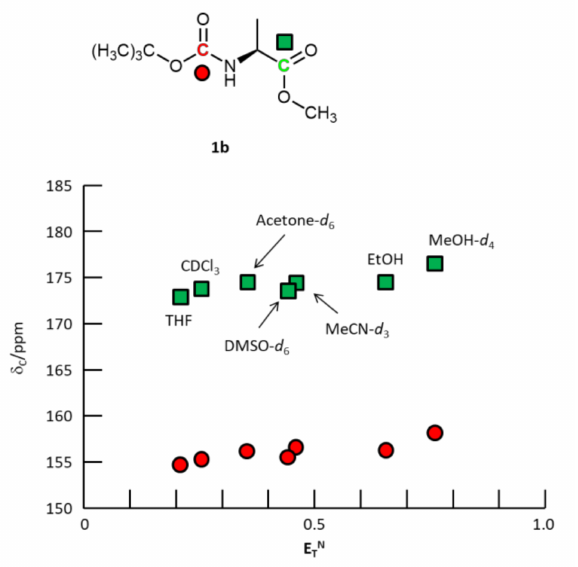
Figure 6. 13 C NMR chemical shifts of the carbonyl carbons of N -Boc-L-alanine-OMe 1b .